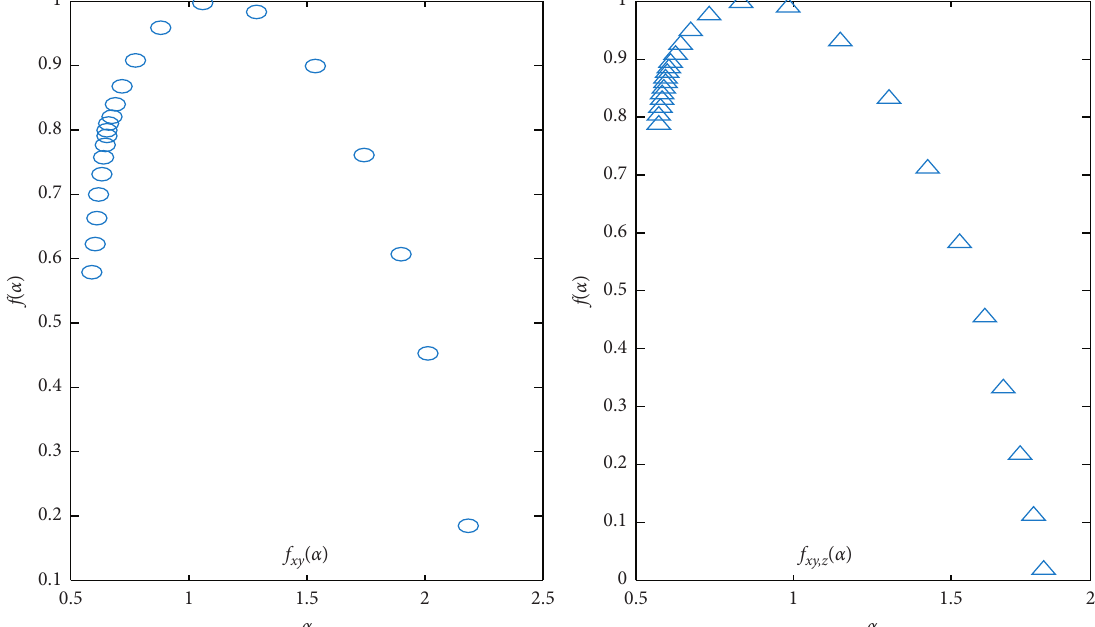
( α ) of bivariate time series xy,z